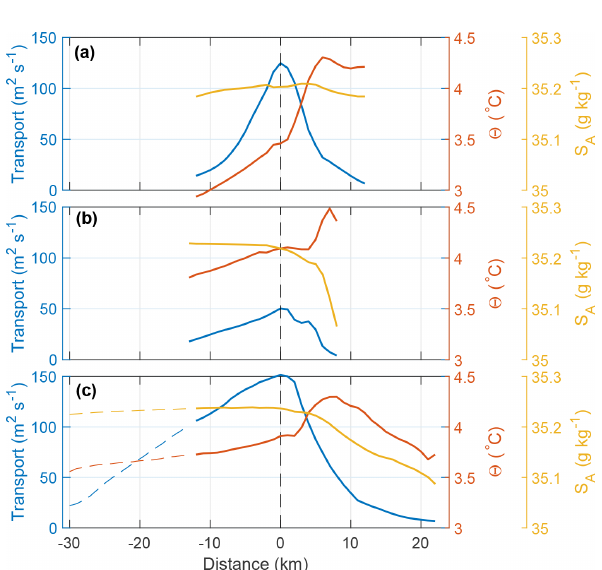
Figure 6. Vertically integrated geostrophic velocity (transport per unit width; blue), and vertically averaged (cid:50) (red) and S A (yellow) for sections (a) A, (b) B and (c) C. The horizontal distance is refer- enced to the core at x =